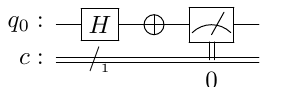
Figure 2 illustrates the quantum circuit for simulating a classical NOT gate, in which only one quantum line q 0 is necessary to perform the calculations and only one conventional line c 1 is necessary to record the result of the measurements. Gate H places the system in a state of superposition, and gate (cid:76) is a quantum NOT.